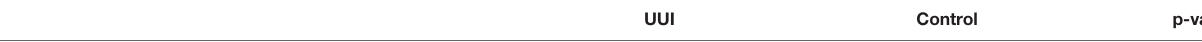
Figure 1 PERMANOVA p = 0.71, adjusted for age, BMI,